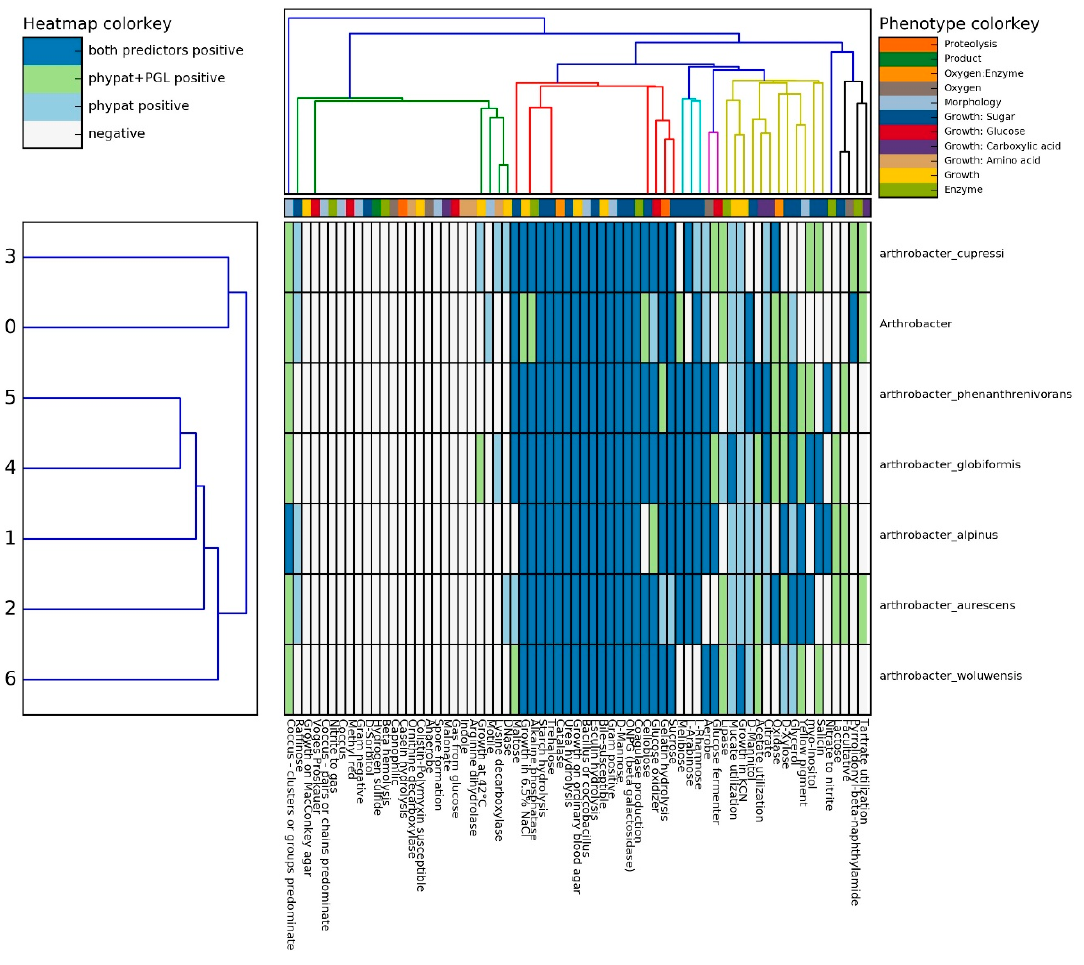
Figure 5. In-silico phenotypic comparison of Arthrobacter sp. SRS W-1-2016 with six closely related Arthrobacter spp. using the Traitar pipeline.